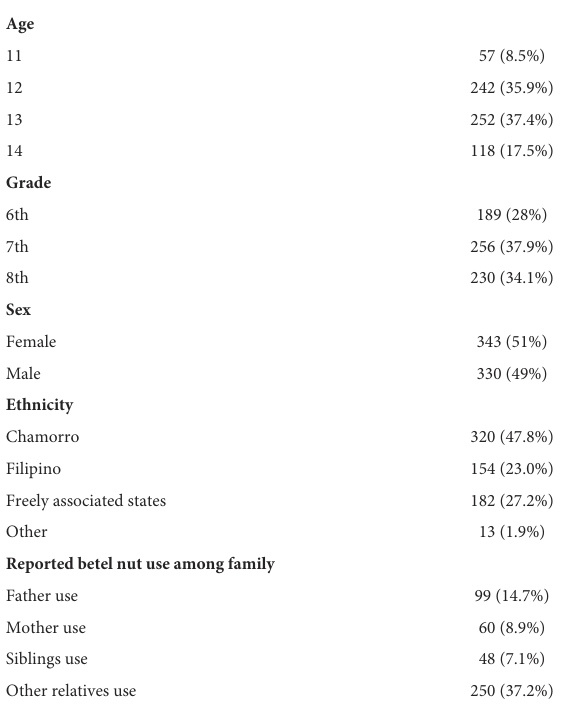
TABLE 1 Participant